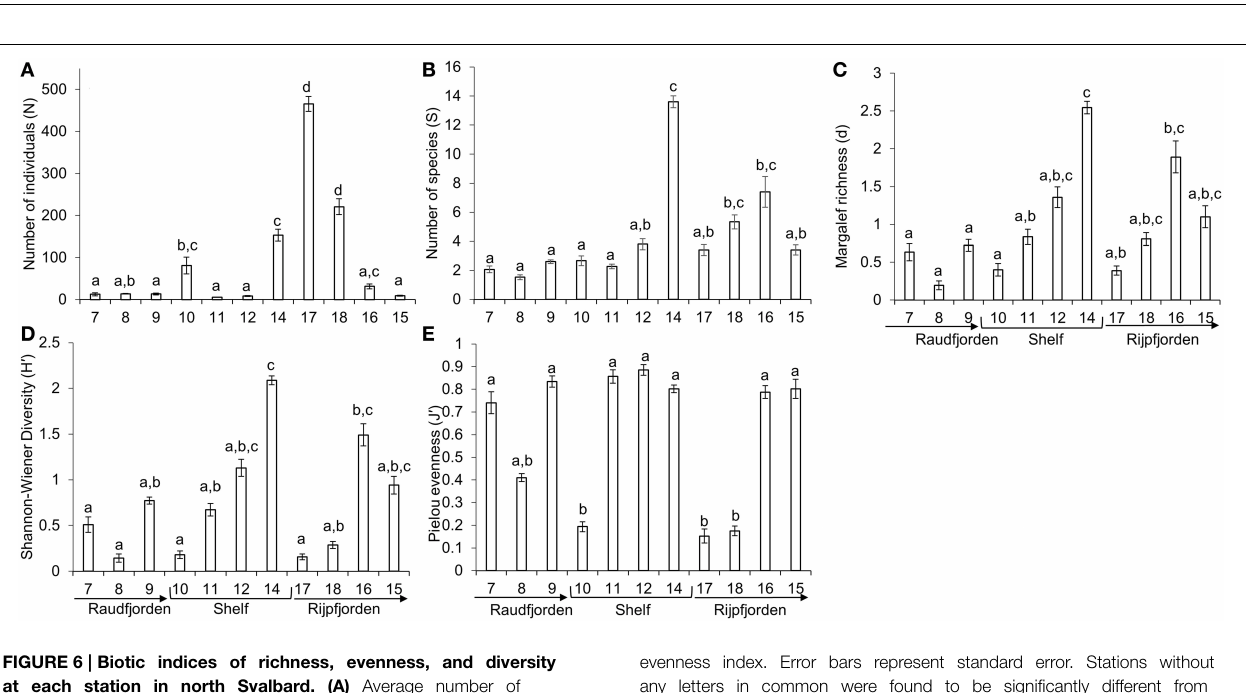
evenness index. Error bars represent standard error. Stations without any letters in common were found to be significantly different from each other in pairwise post-hoc analysis. Arrows point toward fjord